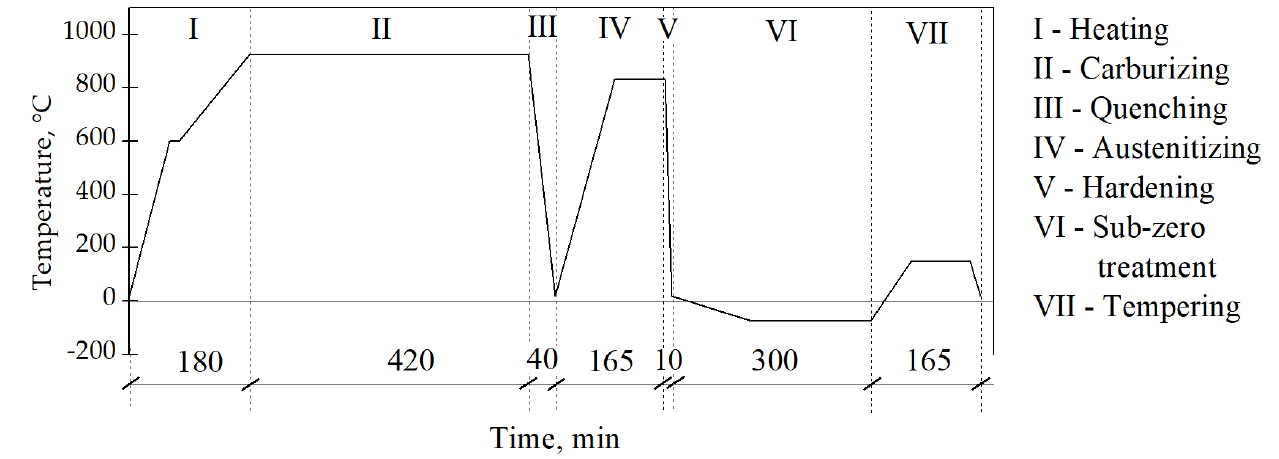
Figure 1. Scheme of the thermo – chemical processing of the AISI 9310 steel. Laser surface heating was performed to produce controlled thermal damage on the surface of carburized samples similar to damage generated by grinding burns (Figure 2).